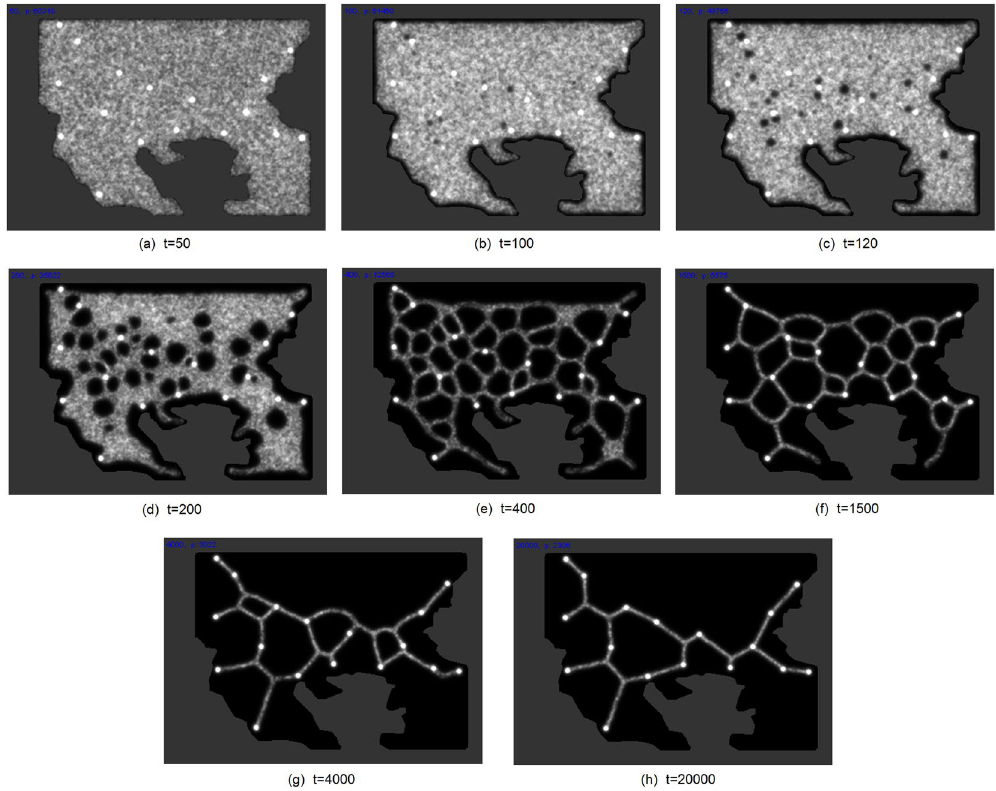
Figure 9. Example evolution of a single experiment with no height representation, particle trails indicated by greyscale values. ( a ) Model Plasmodium inoculated as a single mass completely occupying available locations, ( b ) as adaptation progresses, pores begin to form in the virtual material, ( c – e ) pores grow in size until networks are formed, ( f – g ) network adaptation is constrained by attraction to nutrient stimuli (bright dots), ( h ) stable network is formed (Simulation result snapshots from custom Java simulation of slime mould (https://www. processing.org/) by author J.J.).